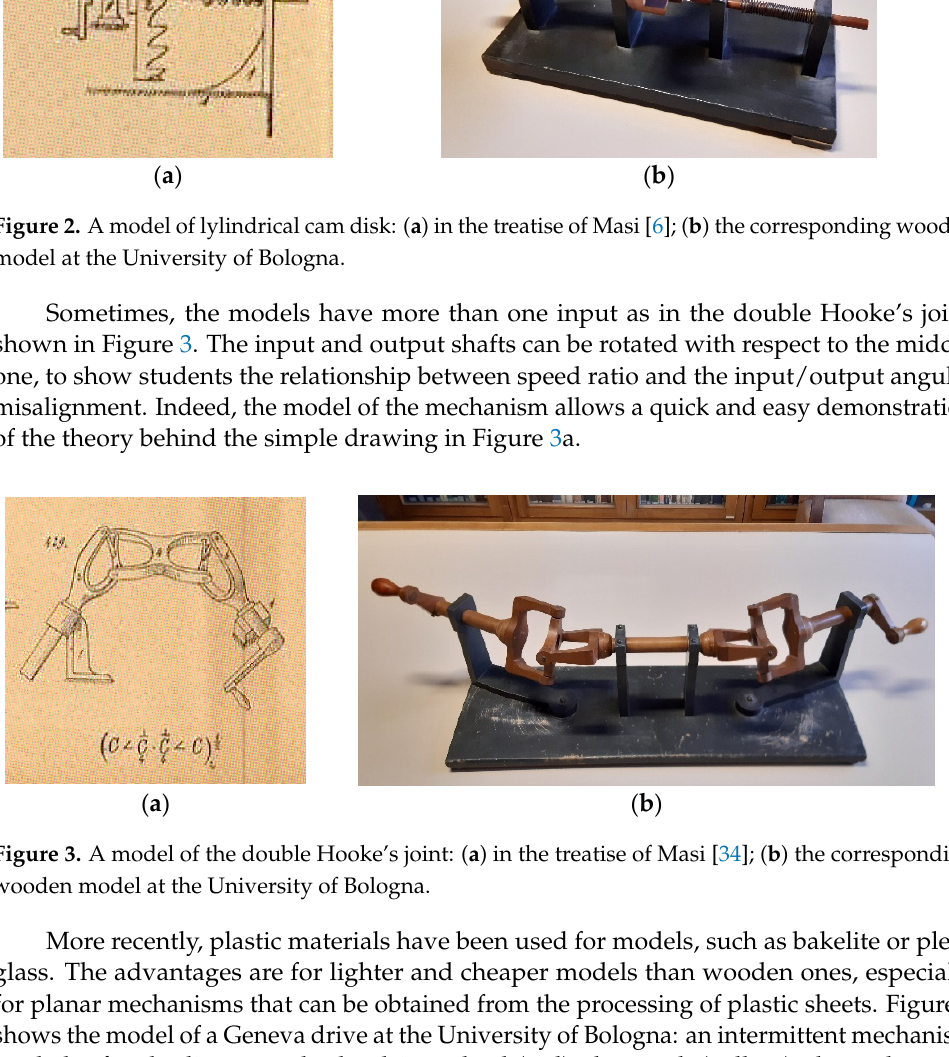
Figure 3. A model of the double Hooke’s joint: ( a ) in the treatise of Masi [34]; ( b ) the corresponding wooden model at the University of Bologna.